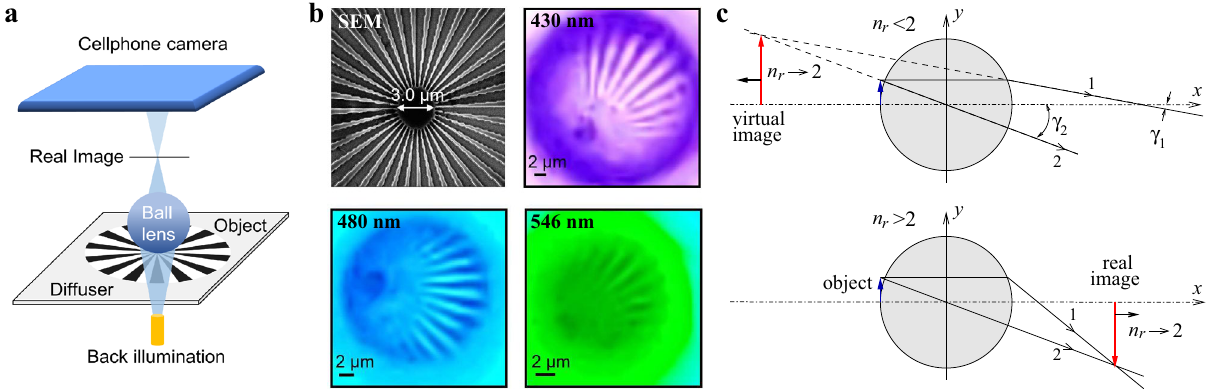
Figure 1. Experimental measurements and imaging regimes. ( a ) Schematic of the experimental imaging through a ball lens using a cellphone. ( b ) Scanning electron microscopy (SEM) image of a Siemens star and its cellphone camera images through the ball (LASFN35 glass, R wavelengths. ( c ) Geometrical optics of imaging with a ball lens for an object at the surface. A virtual image is created for n r < 2 and a real image for n r > 2 . The black arrows indicate the displacement of the image as